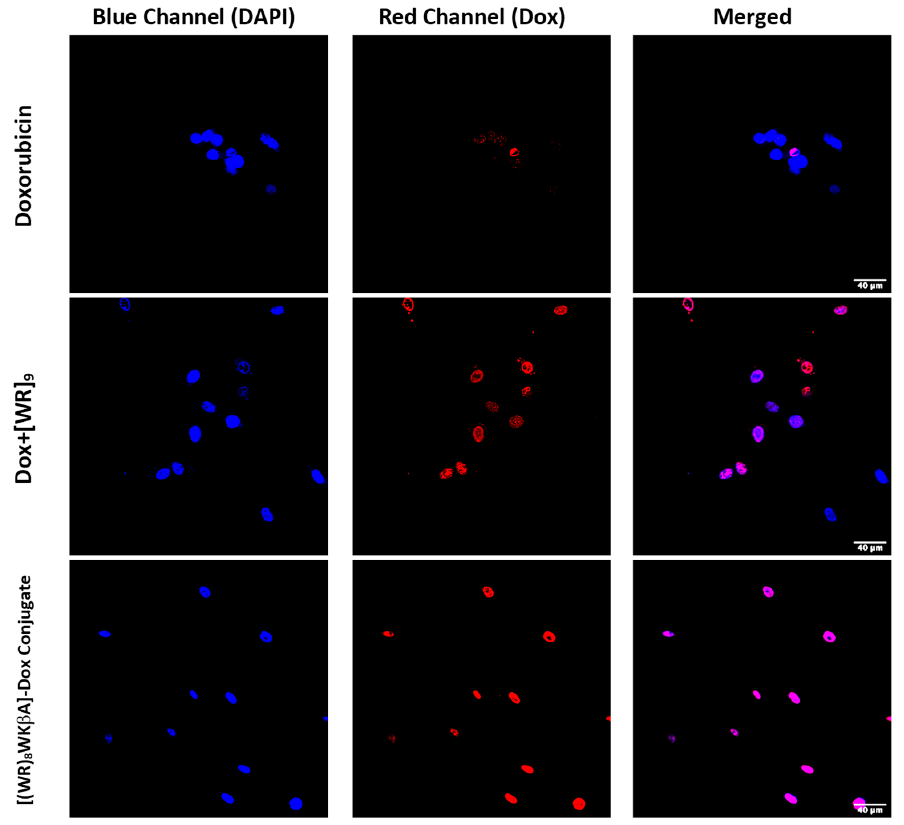
Figure 2. Confocal microscopy images of free Dox (5 µ M), [WR] 9 + Dox (1:1, (5 µ M)) [(WR) 8 WK β A]- Dox conjugate (5 µ M), or after 24 h in SK-OV-3 cells. Red represents the fluorescence of Dox.